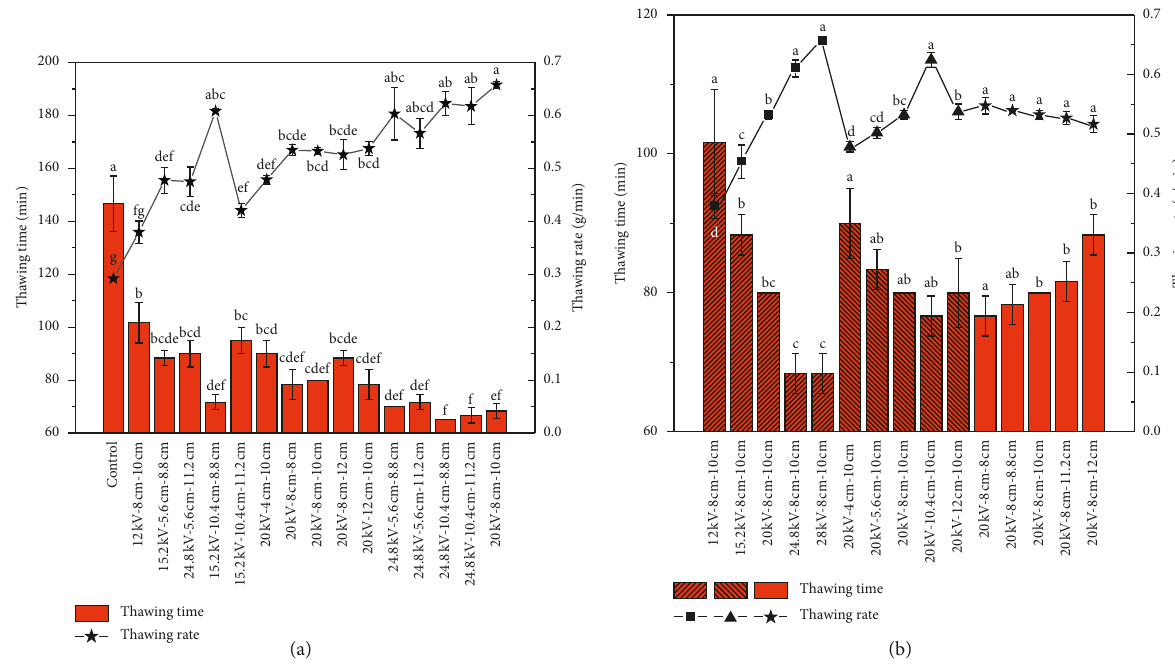
Figure 2: Effect of different treatments on thawing time and thawing rate. (a) The response surface methodology; (b) the single electric parameter analysis. Data are shown as the mean ± SD for each response. For each response, means with different lowercase letters are significantly different ( p < 0 . 05). The order of the parameters is voltage, needle distance, and electrode distance.